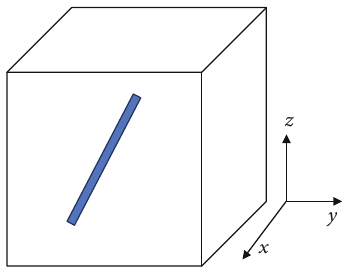
Figure 24: Fiber orientation